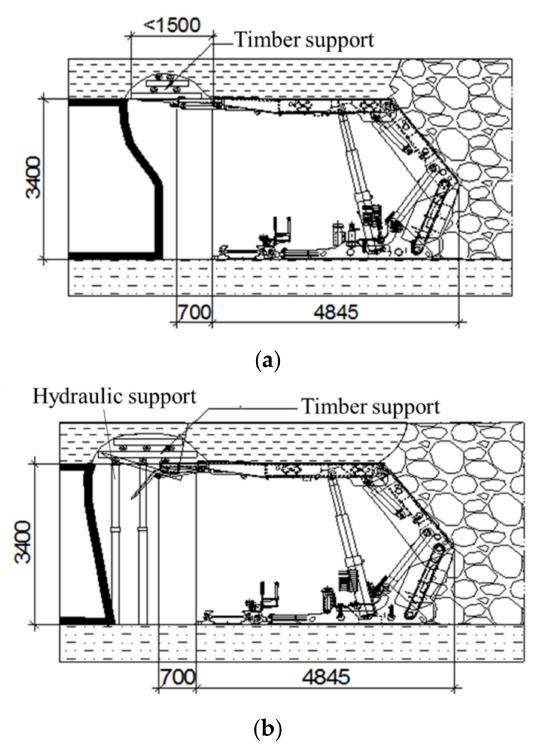
Figure 13. Support structure used during mining construction [15]. ( a ) Small spalling depth-coalface